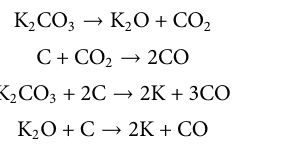
FIGURE 2 FT-IR spectra of